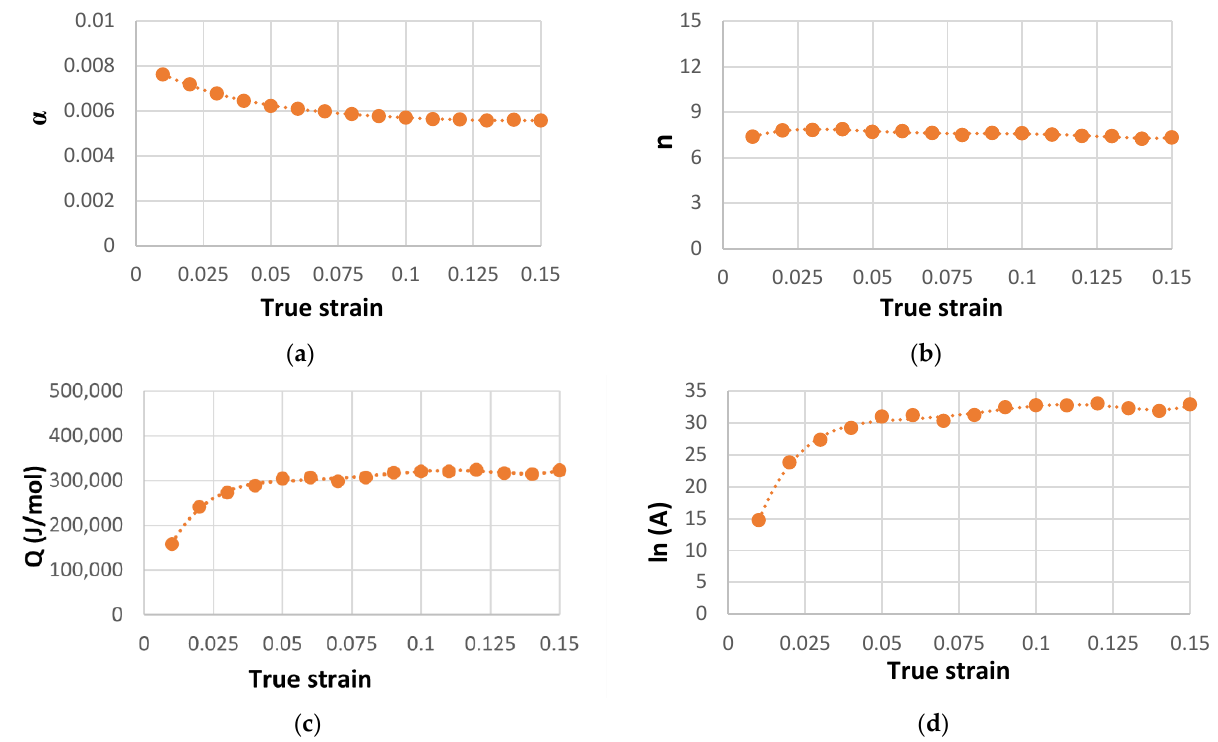
Figure 14. Polynomial fitting curves of material coefficients as a function of strain: ( a ) for 𝛼 ( b ) 𝑛 , ( c ) 𝑄 , and ( d ) ln(𝐴) for the USIBOR ® 1500.